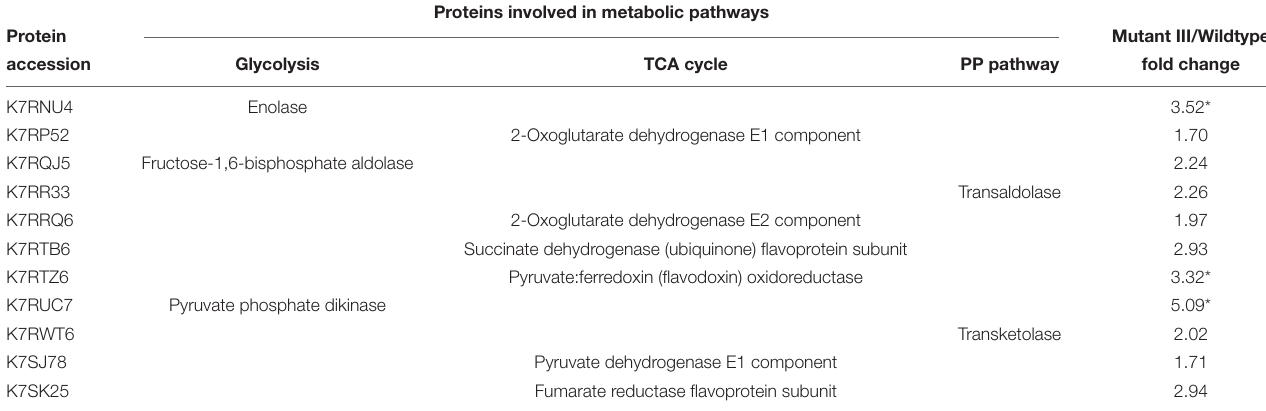
TABLE 3 | Classification of differential expression proteins related to central carbon metabolism.